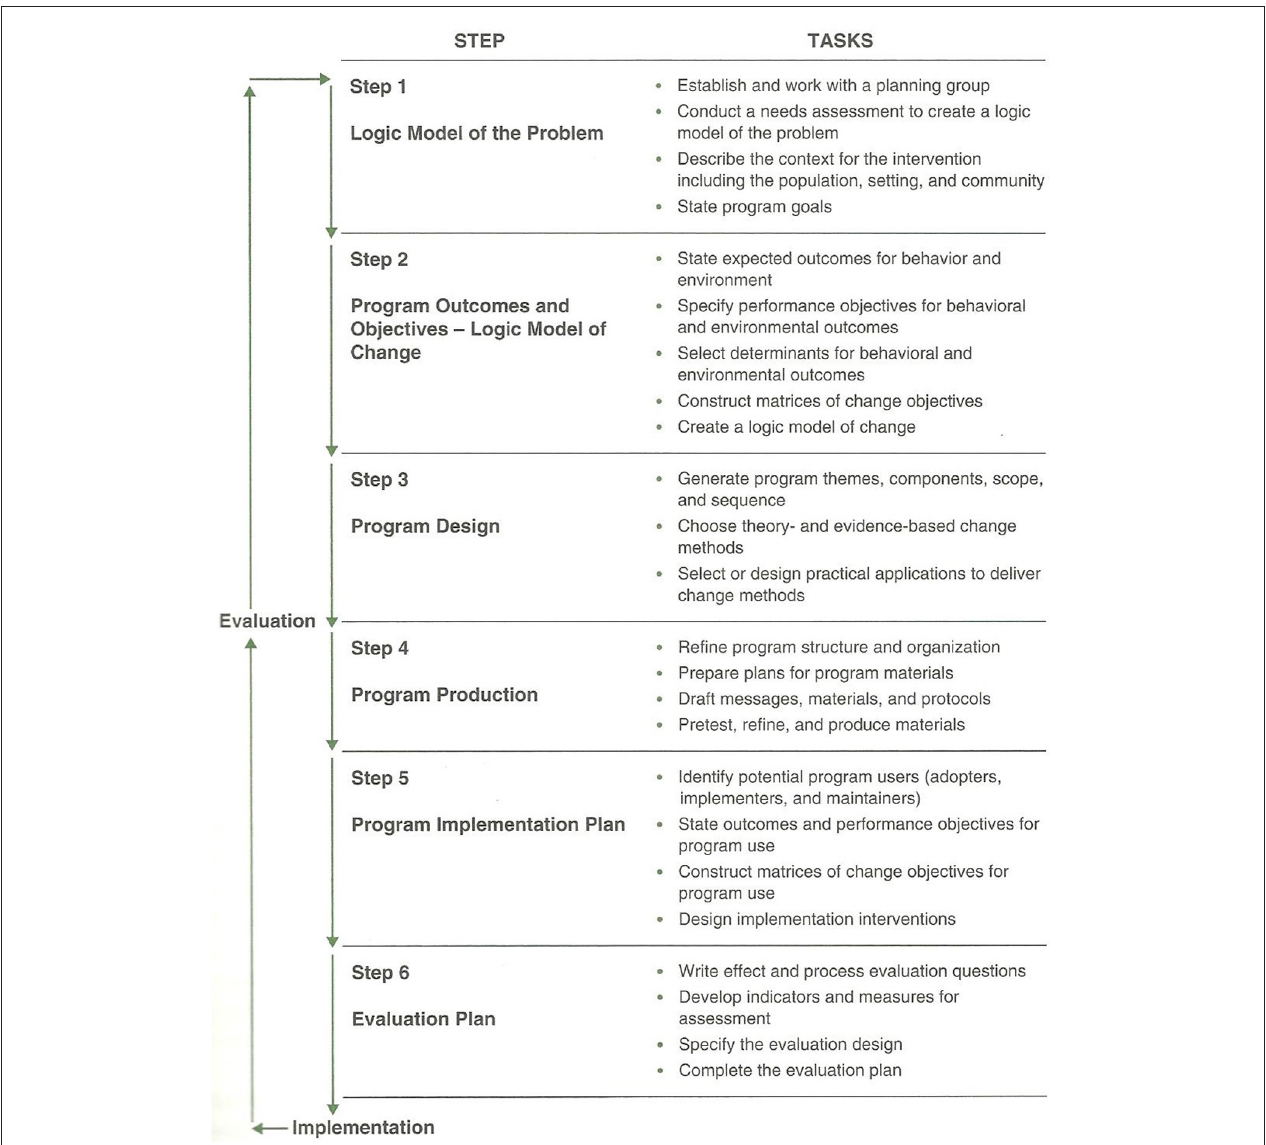
FIGURE 1 | Steps and tasks of the intervention mapping protocol (13) (p.